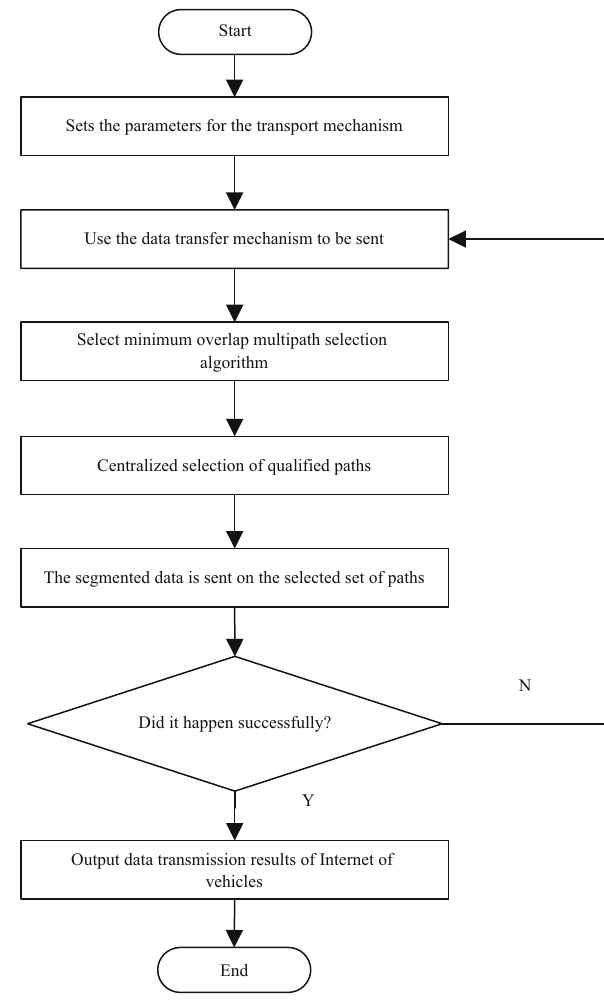
Figure 2: Data transmission fl ow chart of vehicle